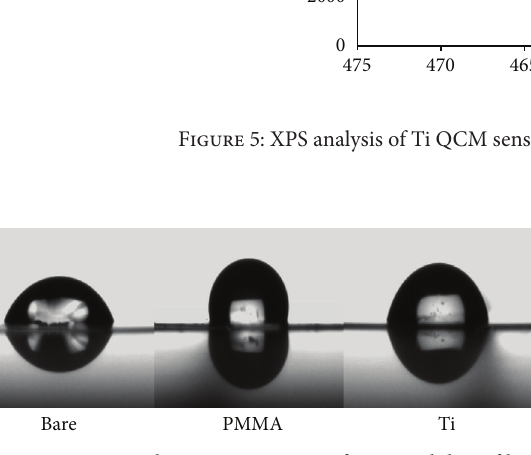
Figure 6: Contact angle measurement. Surface wettability of bare, PMMA, and Ti QCM